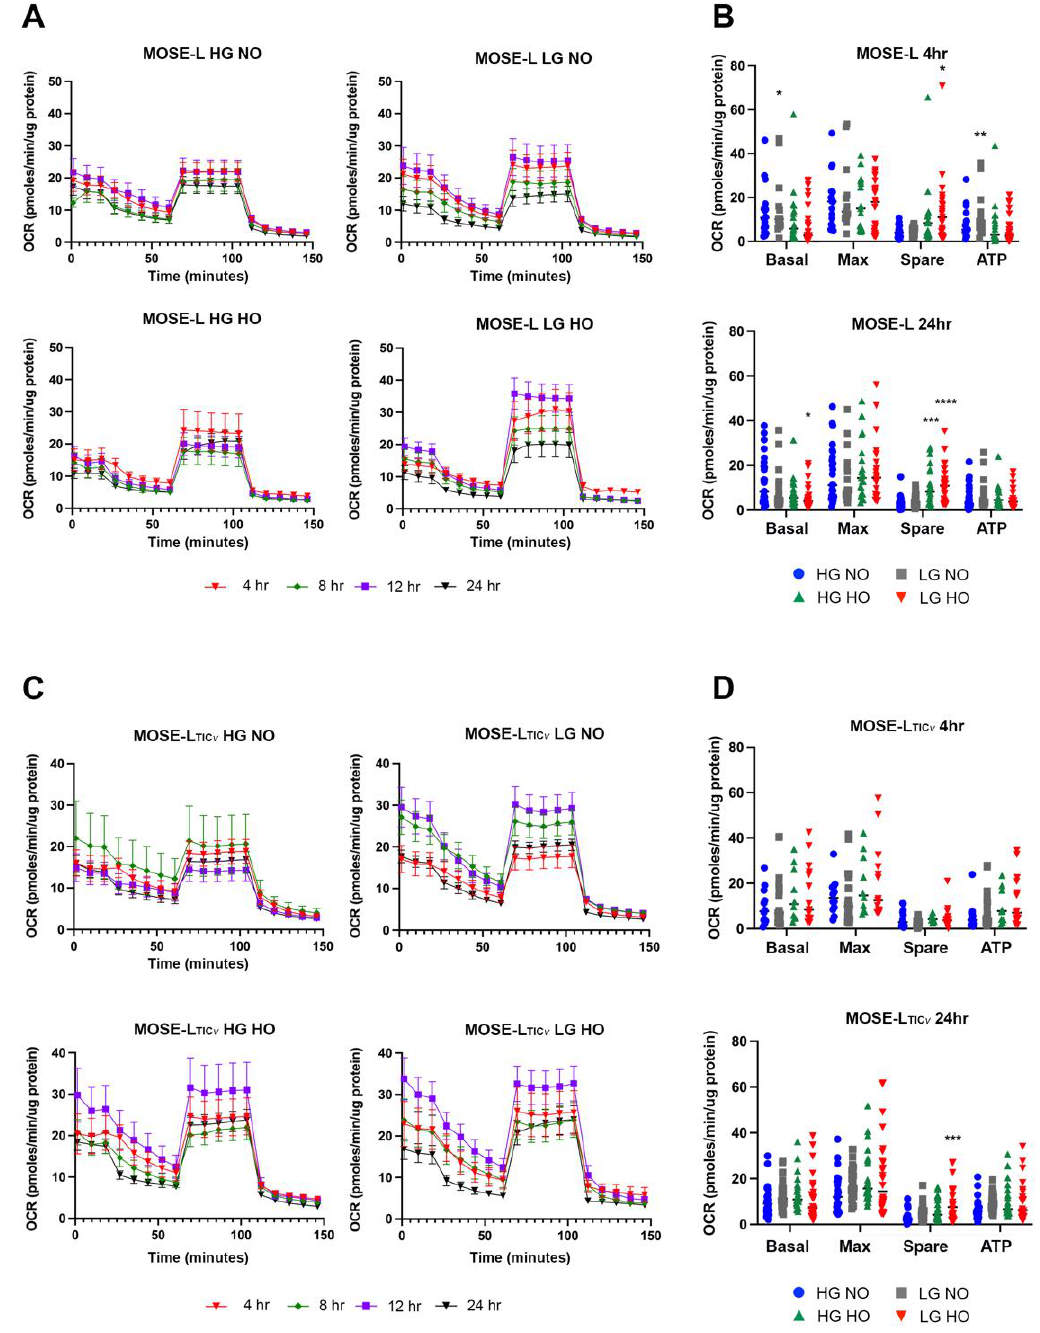
Figure 1. Oxygen consumption rate (OCR) and metabolic outputs in spheroids over time. OCRs were graphed as time traces to compare overall data ( A ) MOSE-L and ( C ) MOSE-L TIC v . Metabolic outputs were calculated from OCR trace values for ( B ) MOSE-L and ( D ) MOSE-L TIC v . Data are represented as the mean ± SEM and ANOVA with Dunnett’s multiple comparisons test to compare to HG NO. * p < 0.05 compared to HG NO; ** p < 0.01 compared to HG NO; *** p < 0.001 compared to HG NO; **** p < 0.0001 compared to HG NO. Abbreviations: high glucose (HG); low glucose (LG); normoxia (NO); hypoxia (HO).